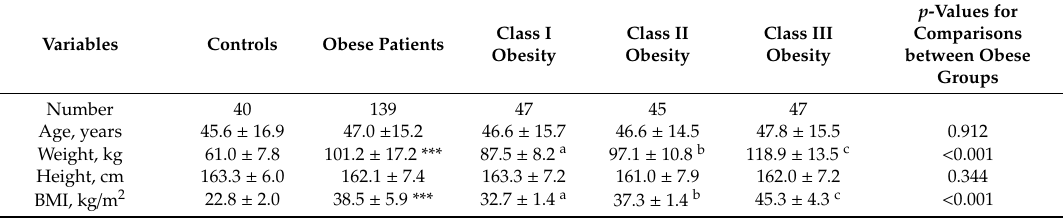
Table 1. Biological and anthropometric characteristics of patients, according to their obesity class, and